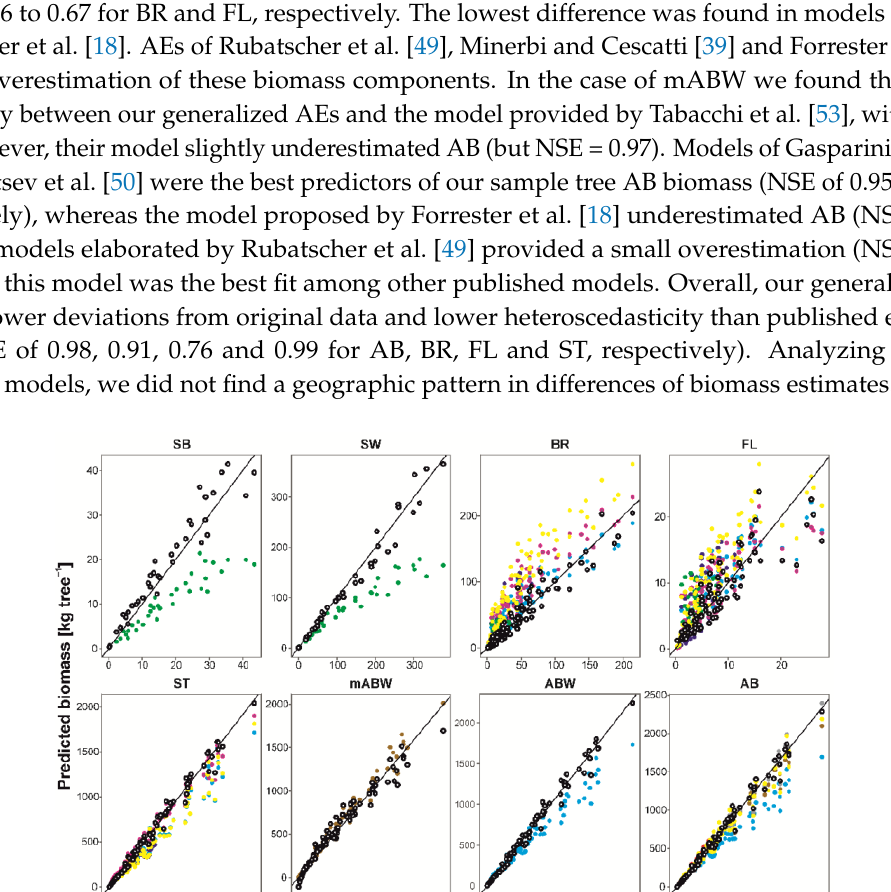
Figure 4. Relationships between forest stand characteristics and forest stand biomass components: total aboveground (AB), branches (BR), foliage (FL) and stem (ST). Parameters of non-linear regression models are presented in Table 4.